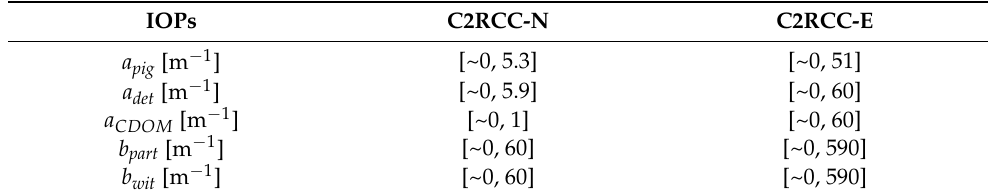
Table 1. The range of IOPs considered in training C2RCC neural